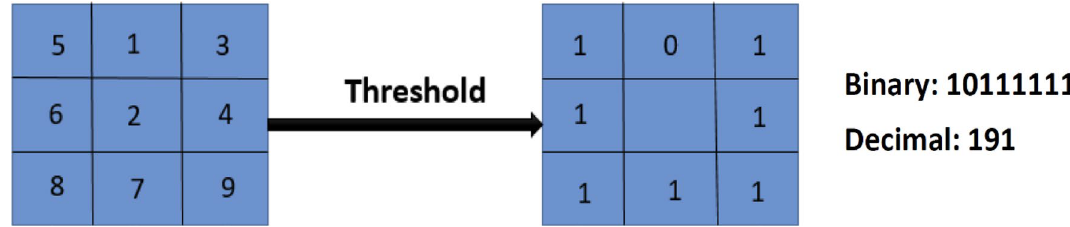
Figure 5. The basic LBP operator which labels the pixels in the